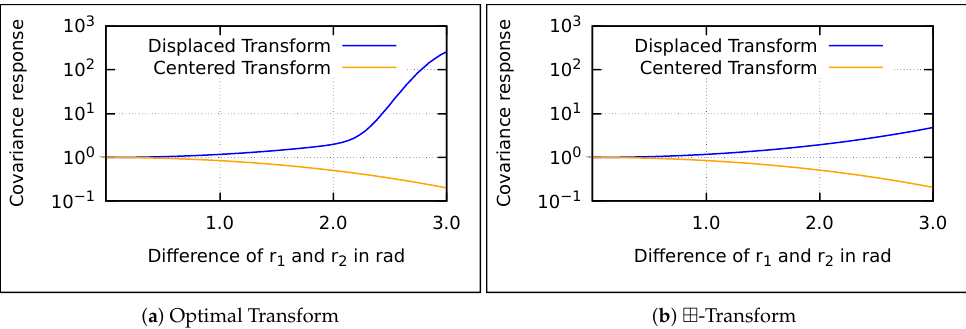
Figure 6. The covariance response in logarithmic scale over the angular differences of r 1 and r 2 . The covariance response is the ratio of the transformed and base covariance